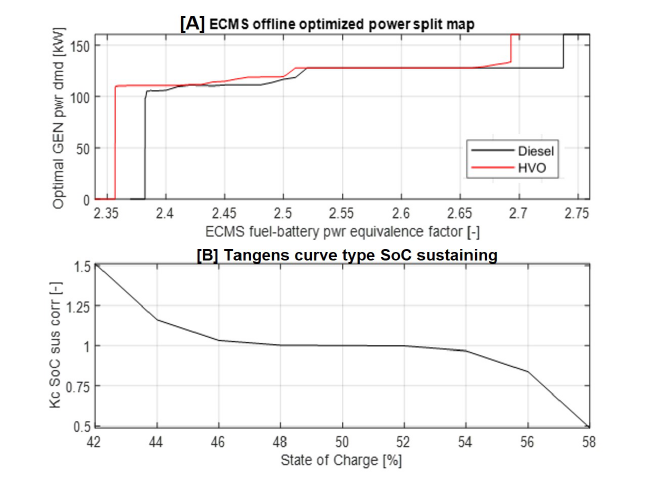
Figure 6. ECMS offline calculation: ( A ) optimal range extender electrical power demand for diesel and HVO cases depending on varying SoC equivalence factor, ( B ) tangens curve of SoC-sustaining correction